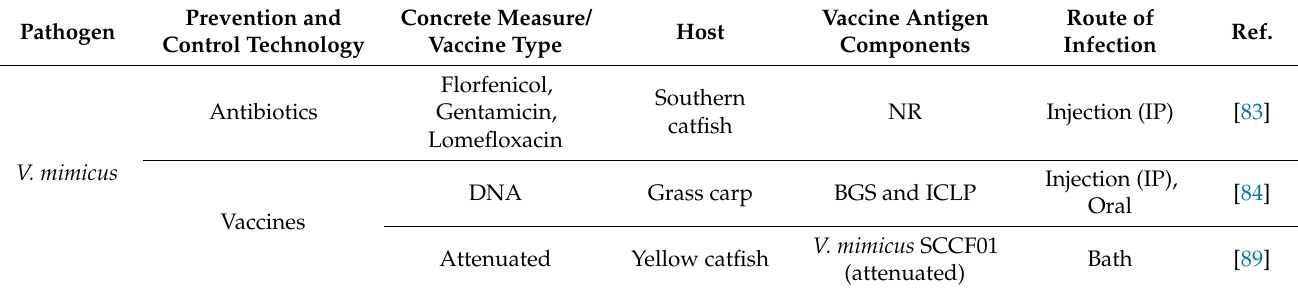
Table 6. Control and prevention strategies of V. mimicus. NR: Not